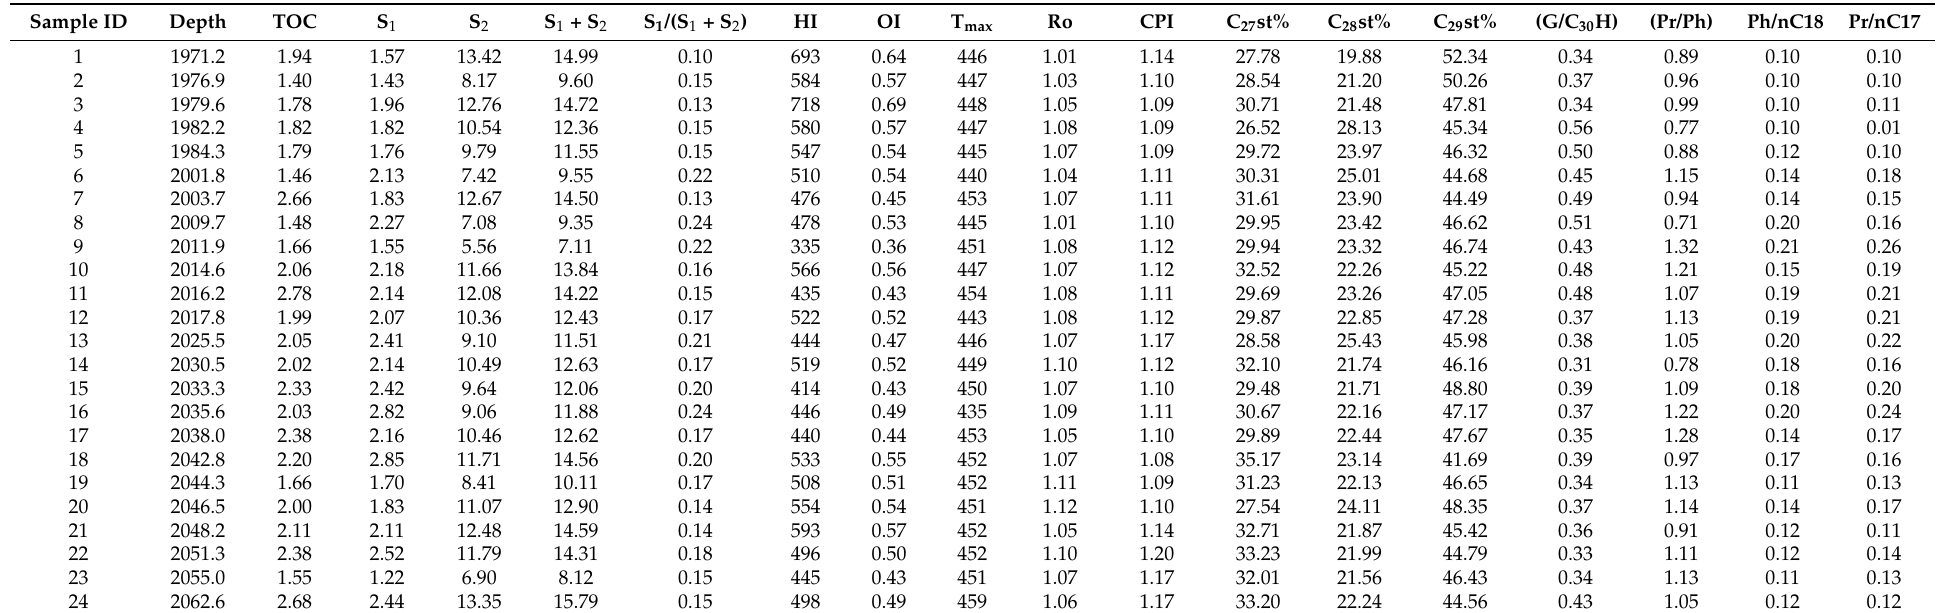
Table 2. Statistics of geochemical biomarker parameters of the Qingshankou lacustrine